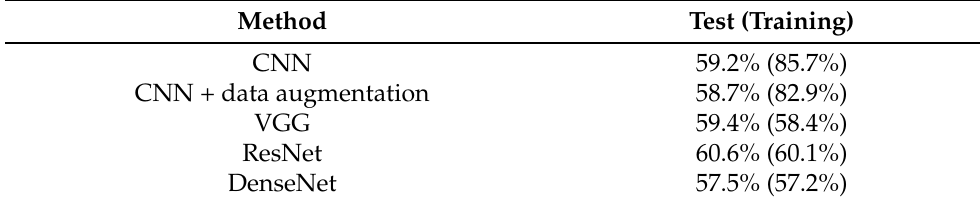
Table 8. Accuracy by age